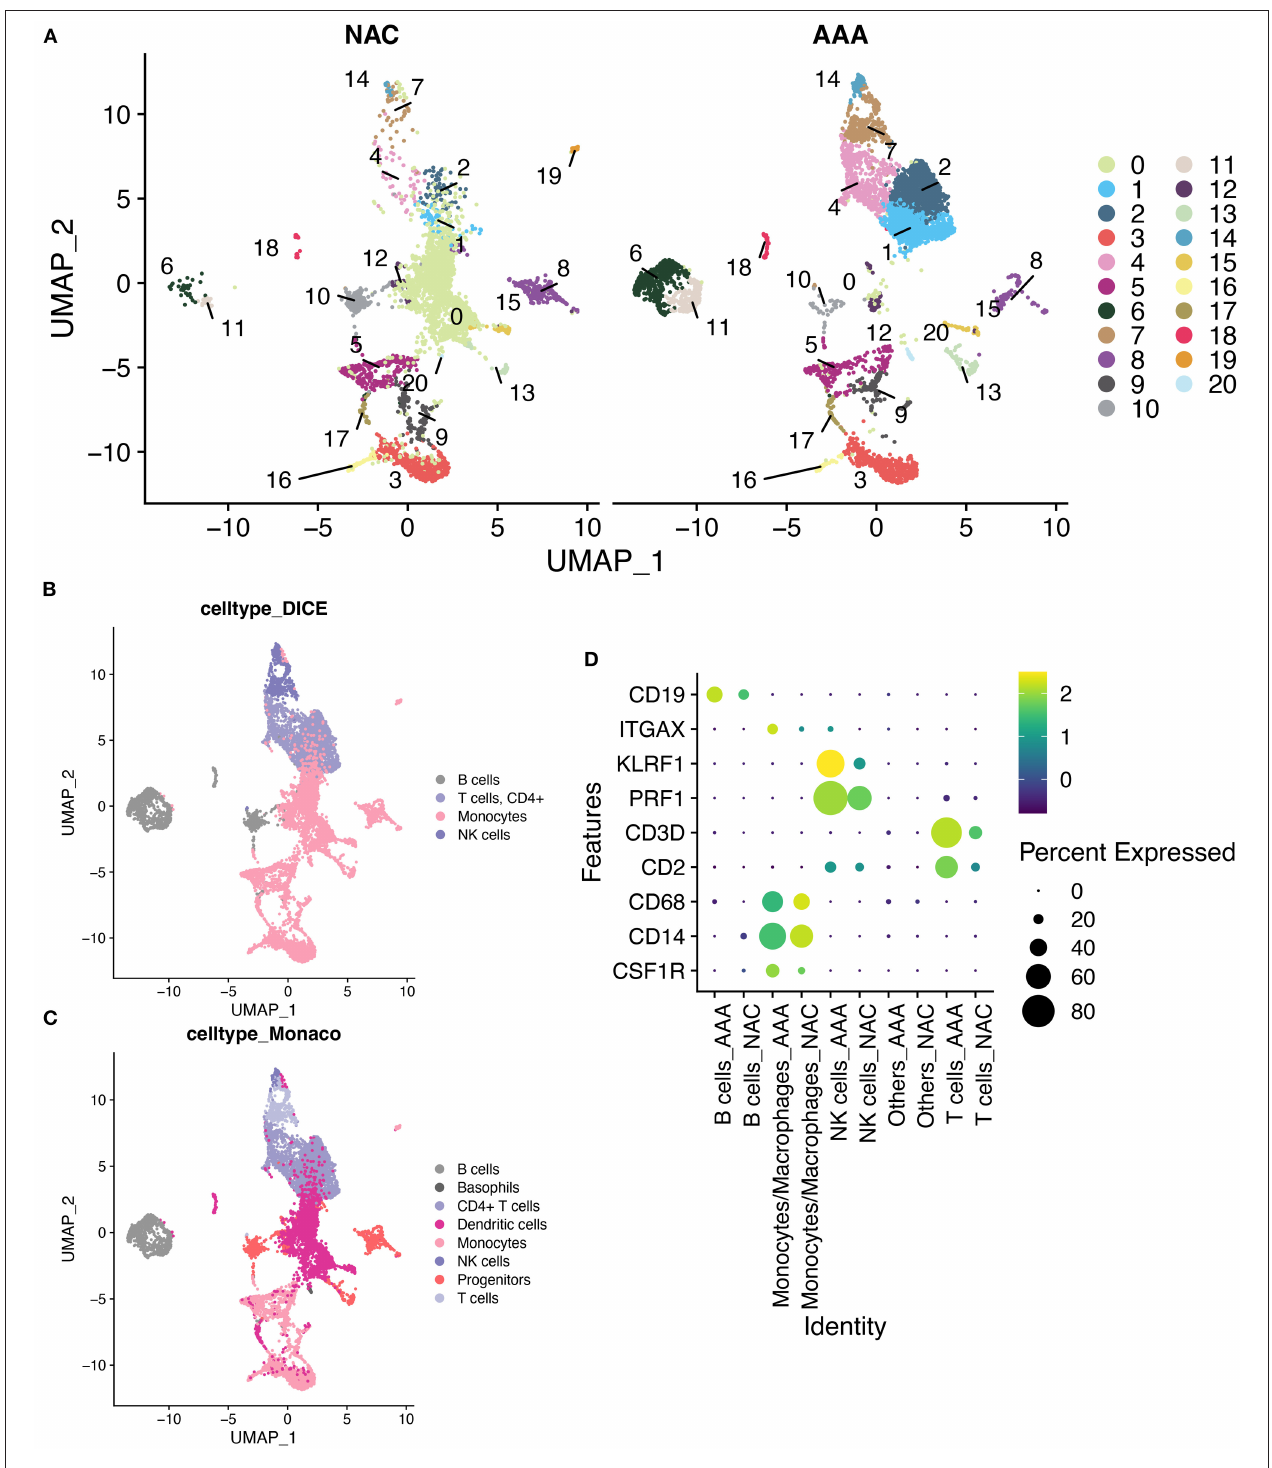
FIGURE 2 | SingleR annotation of cell clusters. (A) The UMAPs show a distribution of 21 cell clusters in the AAA and NAC groups, respectively. (B) . Application of cell annotation to the DICE reference dataset.DICE: Database of Immune Cell Expression (/eQTLs/Epigenomics). (C) Cell annotation using Monaco Immune Cell Data. (D) Heat map showing good concordance in the expression of cellular marker genes between AAA and NAC groups.